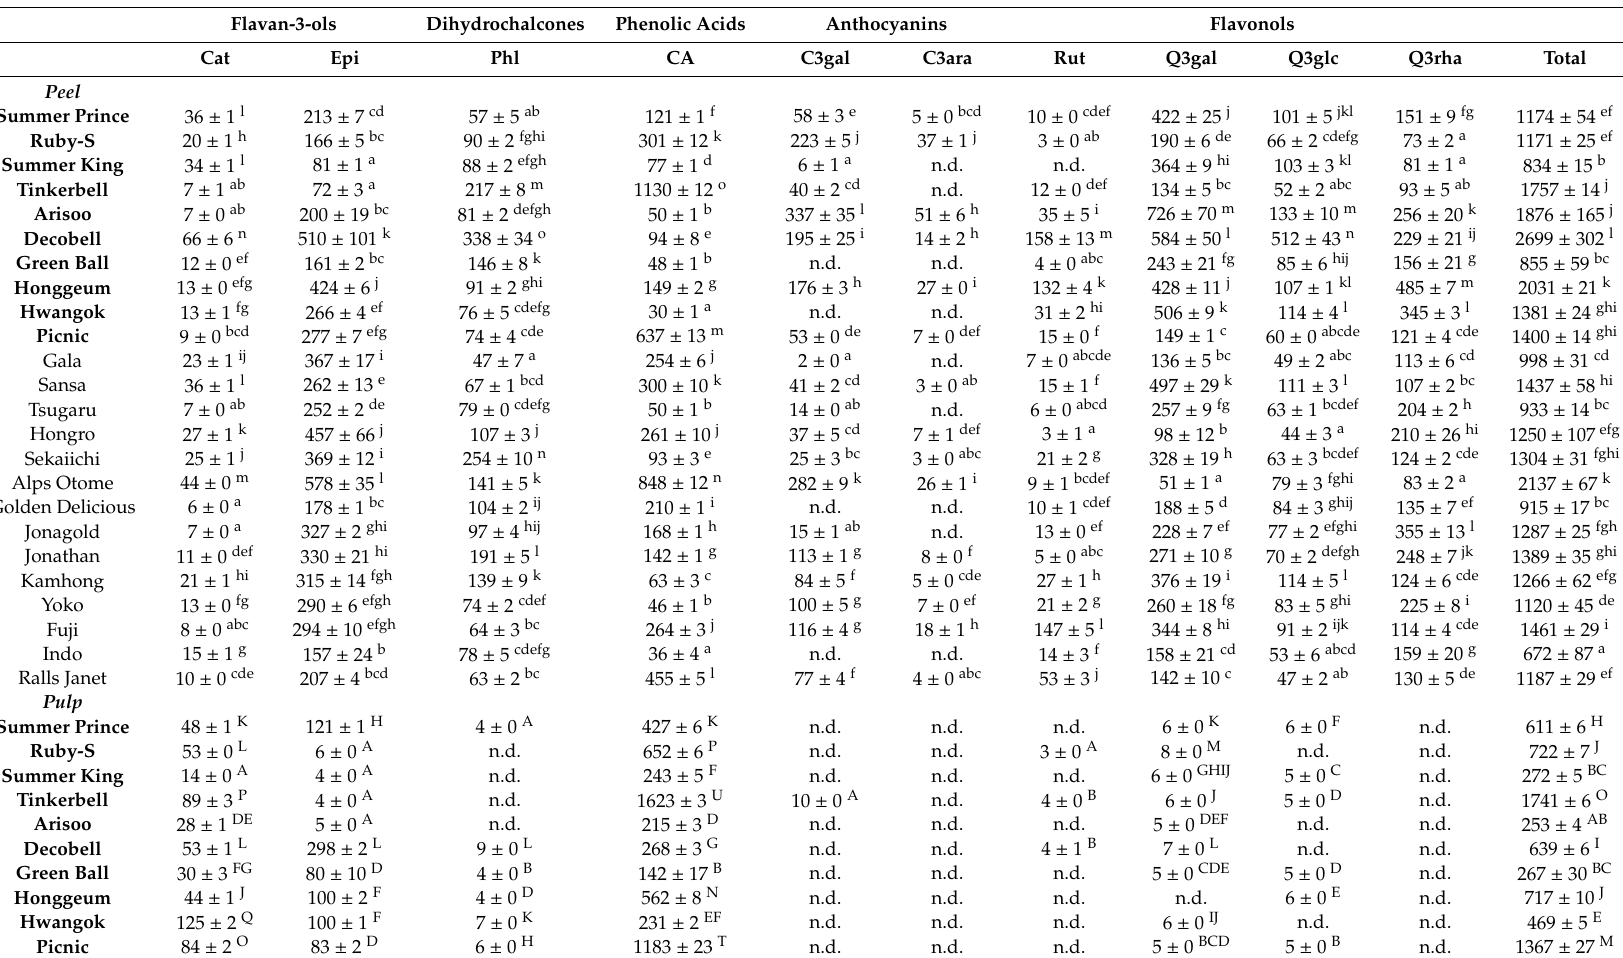
Table 3. Content of phenolic compounds in the peel and pulp of 24 apple cultivars by HPLC ( µ g / g